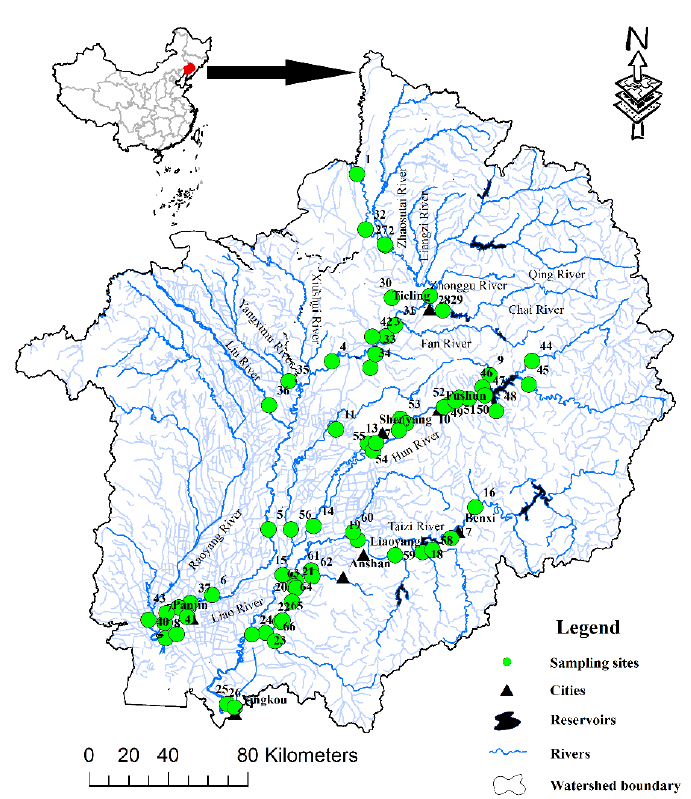
Figure 1. Study area and water quality sampling sites.